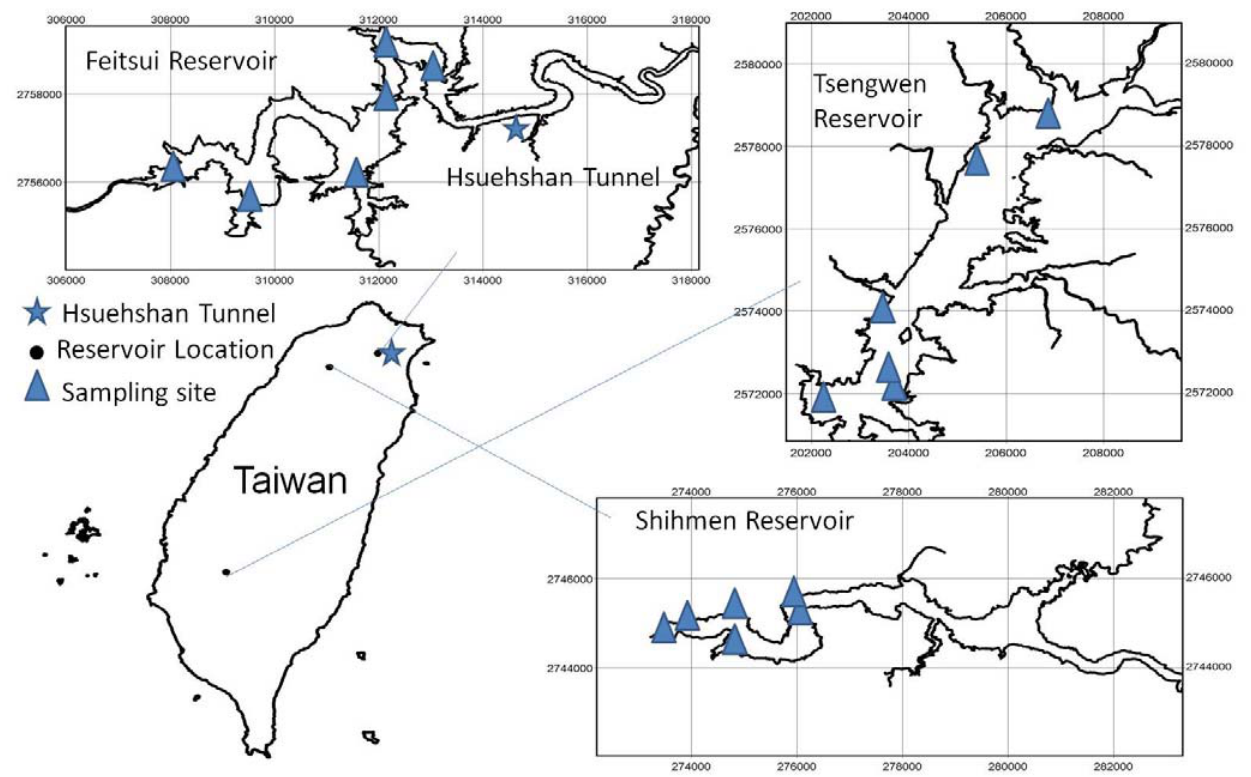
Figure 1. Research